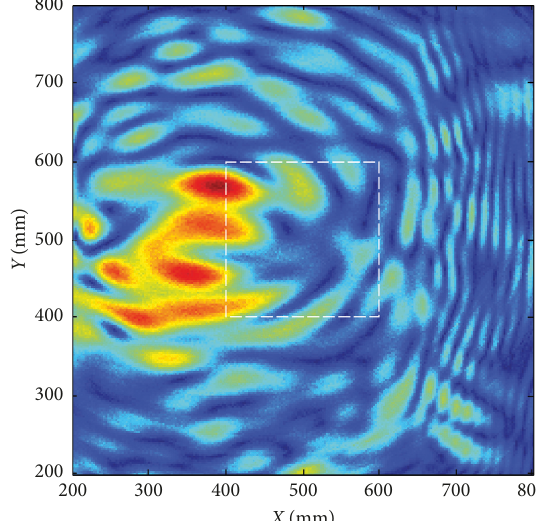
Figure 12: SAFT imaging experimental results.